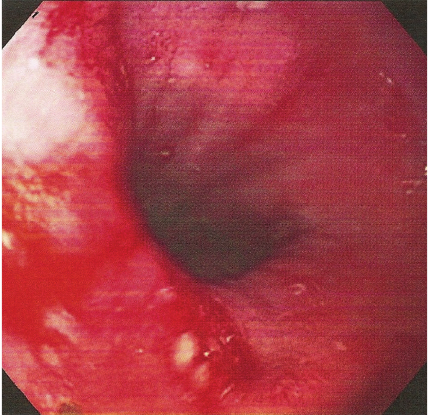
Figure 2: Hiatal hernia discovered during endoscopy.